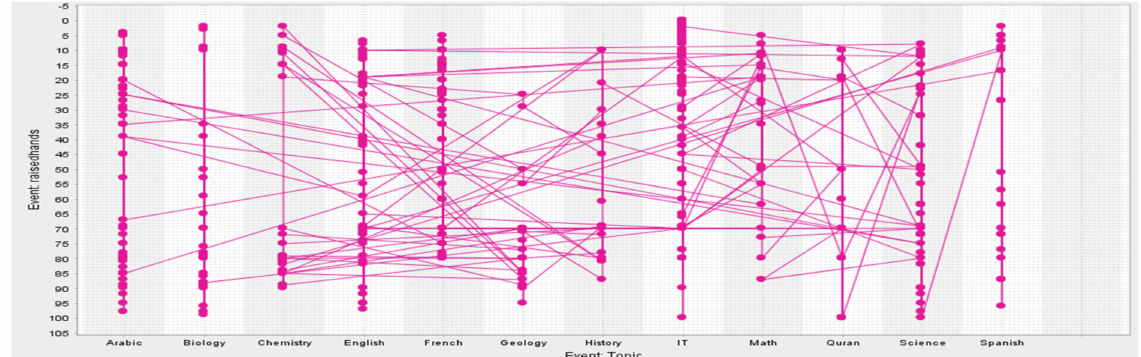
Figure 7. Dotted chart showing connected events between the topic studied and hands raised.